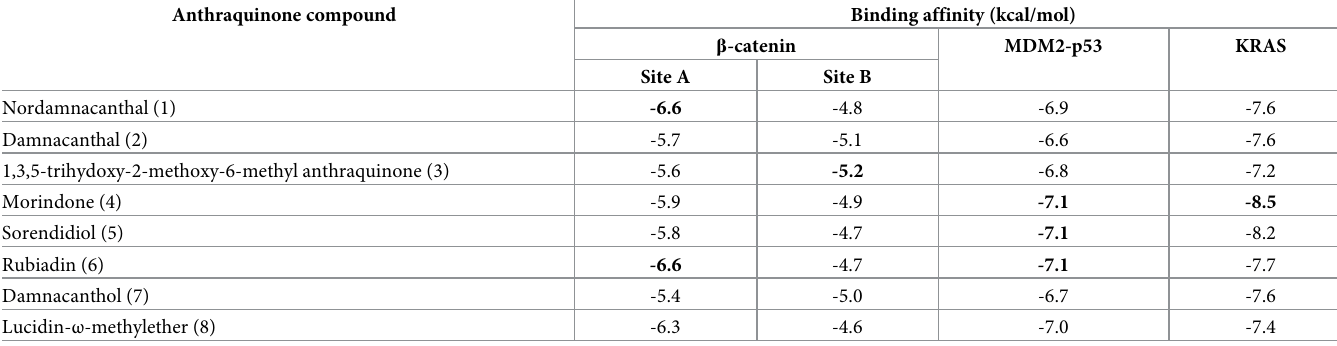
Table 1. Binding affinity of anthraquinone compounds 1–8 towards β -catenin, MDM2-p53 and KRAS in colorectal